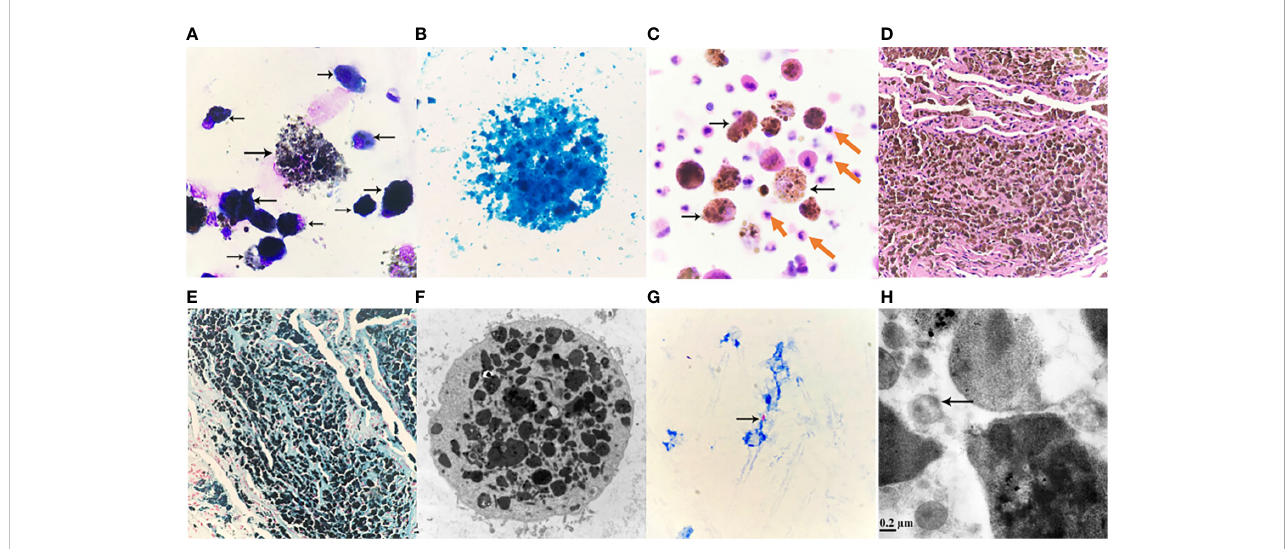
FIGURE 2 (A) Alveolar lavage fl uid Wright-Giemsa Stained ×1000. Nucleated cells are signi fi cantly increased, easy to see piles, or scattered macrophages, macrophages can be seen round, or circular; soma medium in size, or enlarged; Swallow a large number of black gray, or brown-black particles, different sizes, different